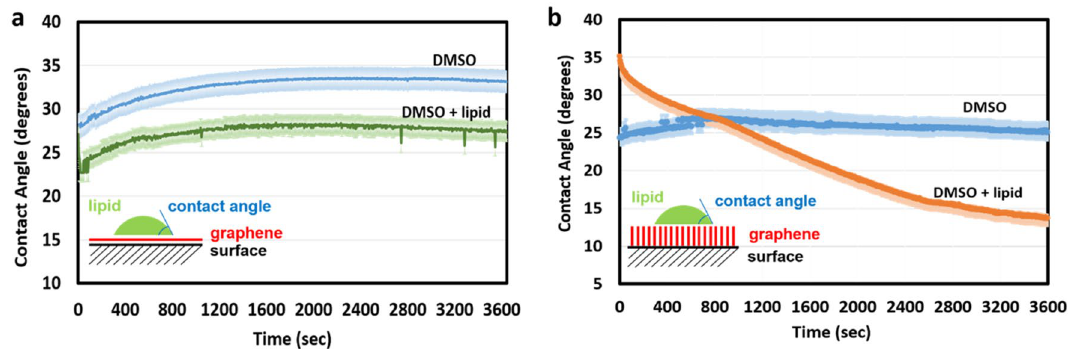
Figure 1. Time lapse measurements of contact angle of lipid droplets diluted in 5% dimethyl sulfoxide on ( a ) surface coated with monolayer graphene deposited parallel to the coated surface and ( b ) surface coated with vertically oriented graphene, perpendicular to the coated surface. 5% of dimethyl sulfoxide was used as a negative